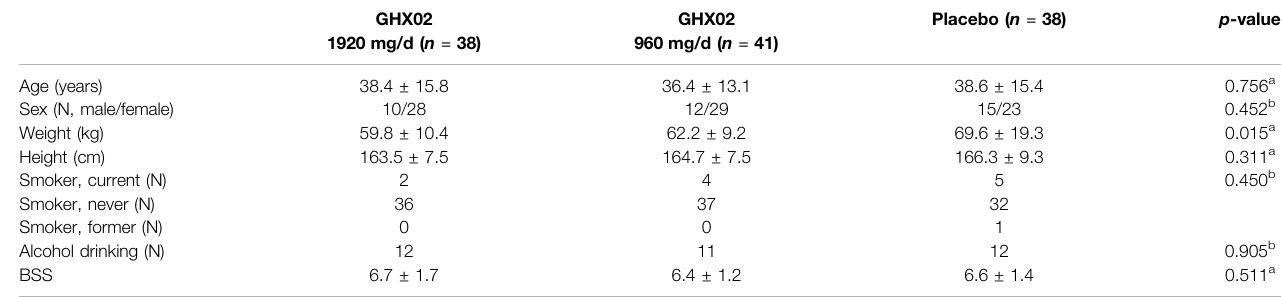
TABLE 3 | Baseline